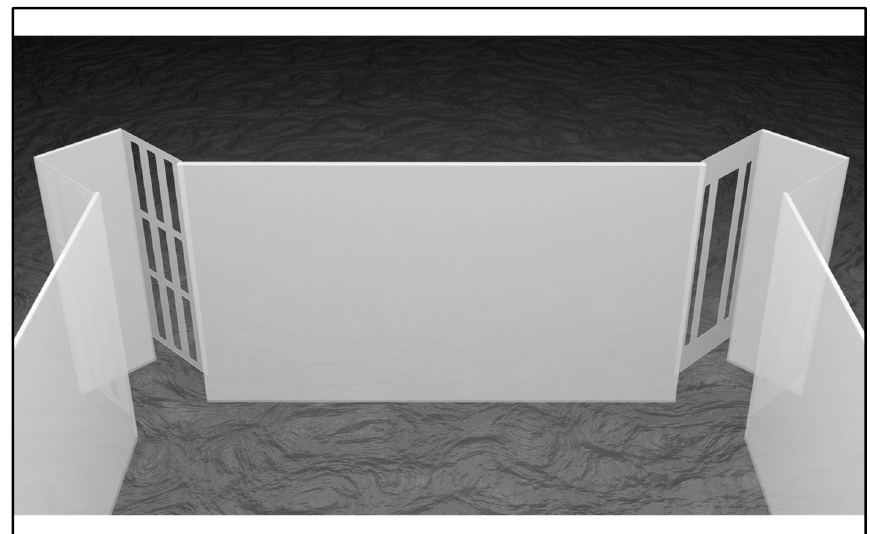
Figure 1. Detail of corridors. At level of the arena’s corners, four corridors (two per side) made of glass and acetate were placed: two traversable corridors having a large central hole were arranged on the correct-geometry diagonal, whereas two nontraversable corridors having smaller holes were arranged on the incorrect-geometry one. While the former allowed fish to exit the arena, thus achieving food and companions, the latter did not.